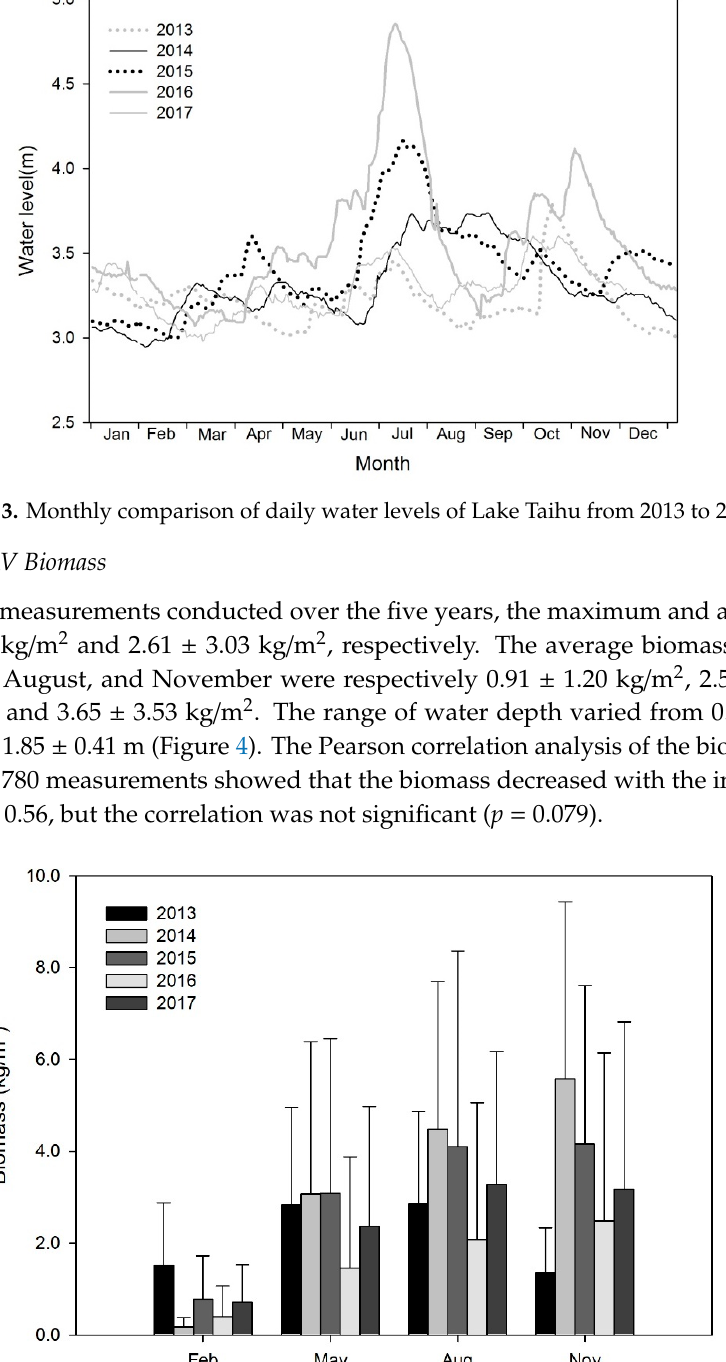
Figure 4. The average biomass for each season from 2013 to 2017. Vertical bars indicate standard standard deviation. Table 1. Statistical analysis of the effect of water depth on aquatic vegetation biomass.